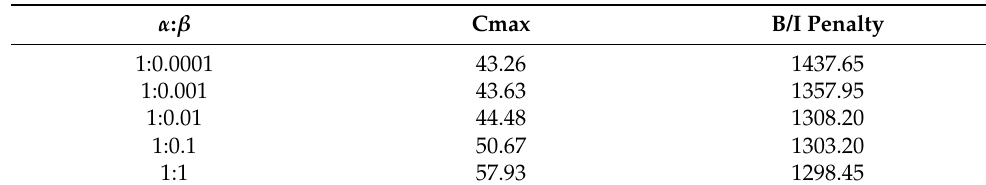
Table 2. The impacts of α and β on the objective value.